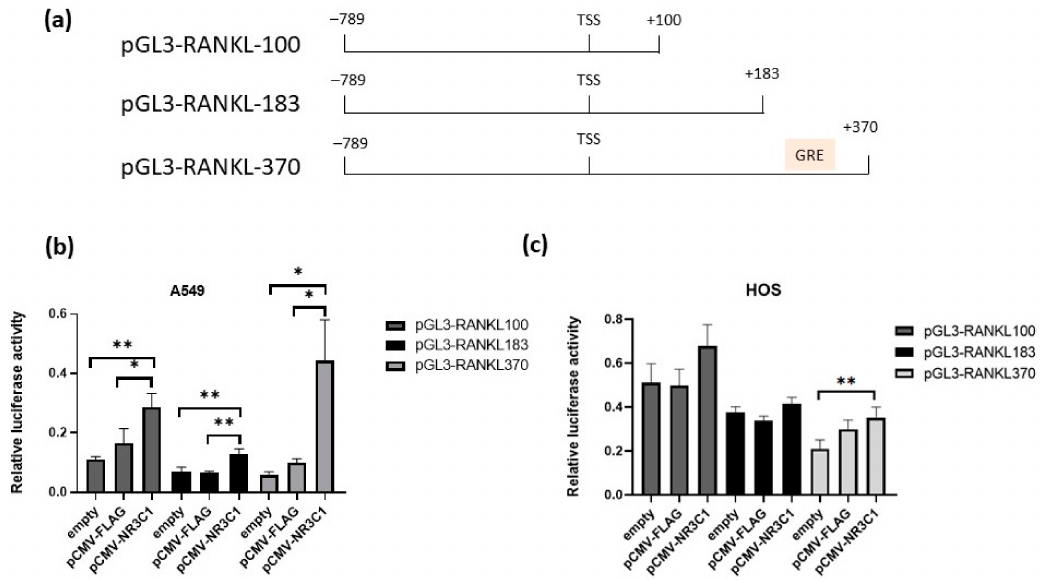
Figure 2. Glucocorticoid receptor NR3C1 potently increases RANKL promoter activity of the region including a novel Glucocorticoid Responsive Element (GRE) at +352 site. ( a ) Schematic representation of the human RANKL promoter region employed in the luciferase assays. Region from − 789 to +370 relative to the transcription start site (TSS) and two length deletions were employed in the study. A novel glucocorticoid response element (GRE) at the site +352 is depicted pink in construct pGL3-RANKL-370. ( b ) A549 cells were co-transfected with the luciferase reporter constructs harboring three RANKL promoter regions (pGL3-RANKL100, pGL3-RANKL183, pGL3-RANKL370) and 24 h after transfection luciferase activity was measured. Relative luciferase activity is shown and it was calculated by normalization of Firefly luciferase activity to Renilla luciferase activity. ( c ) HOS cells were co-transfected with the luciferase reporter constructs harboring three RANKL promoter regions (pGL3-RANKL100, pGL3-RANKL183, pGL3-RANKL370) and 24 h after transfection luciferase activity was measured. Relative luciferase activity is shown and it was calculated by normalization of Firefly luciferase activity to Renilla luciferase activity. All the experiments were performed at least three times independently in parallels. The results are expressed as the mean ± SEM. *– p < 0.05, **– p < 0.01.